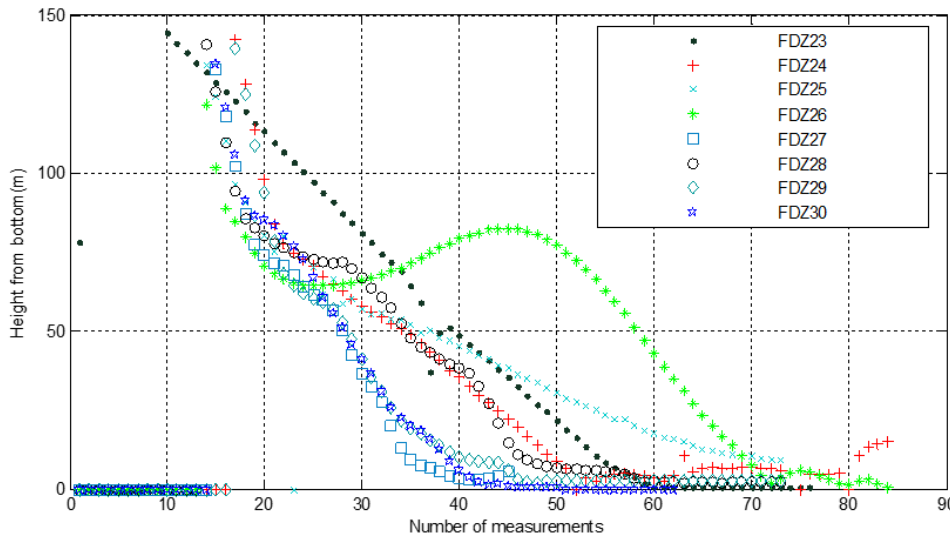
Figure 18. Range map of OAS in the positive downward direction.